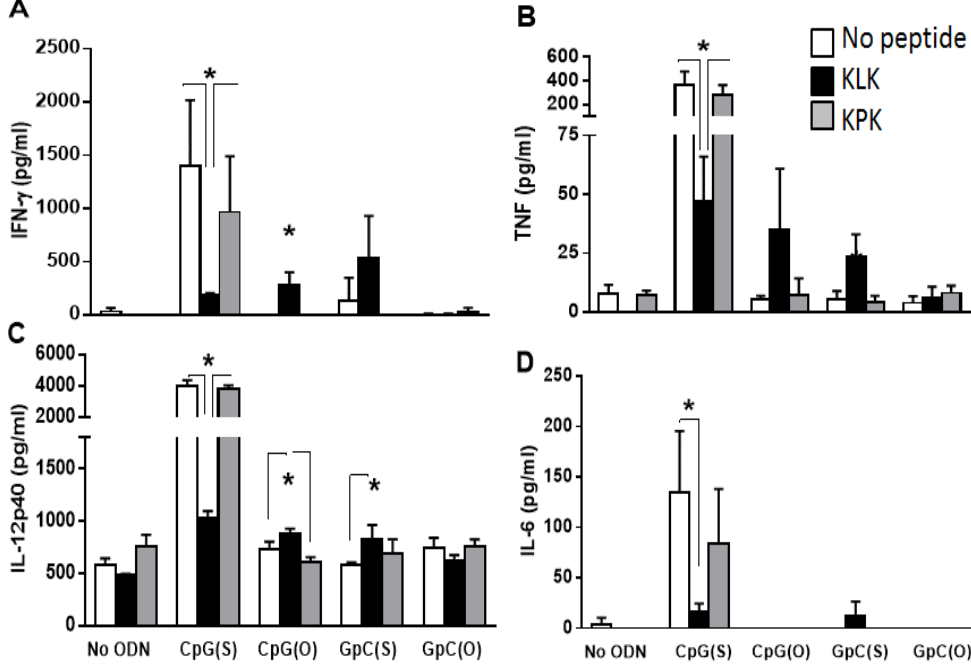
Figure 3. Wild type C57Bl/6 mice ( n = 5/group) were injected with unadjuvanted OVA (10 µ g) or OVA adjuvanted with CpG(S), CpG(O), GpC(S), GpC(O) ODN (4 nmol) alone or in combination with KLK peptides (100 nmol). Mice were bled at 24 h post injection plasma cytokine levels were measured by ELISA. Bars represent the group mean (± SEM). Significant differences between groups is shown by * where * = p < 0.05.